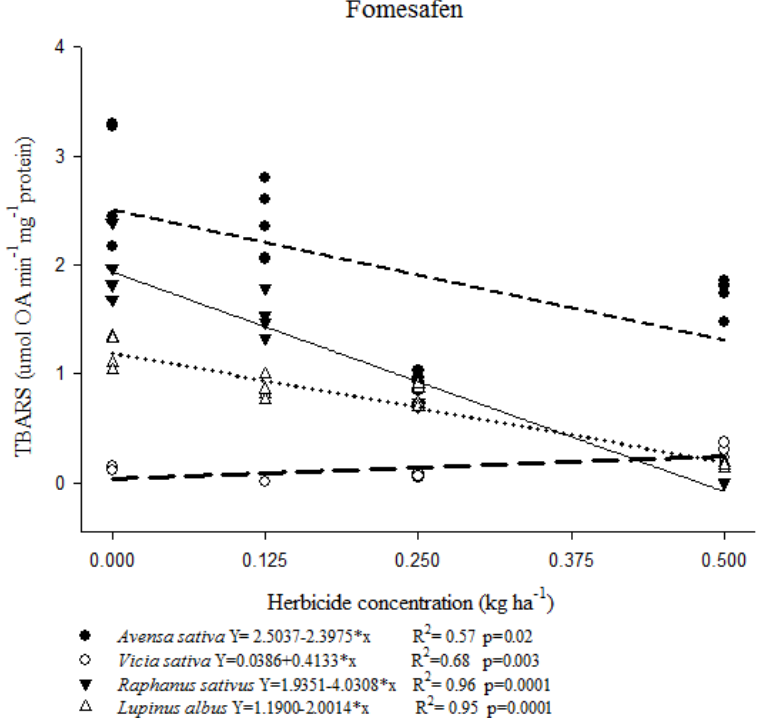
Figure 5 - Effect of fomesafen on lipid peroxidation in different crop plants.